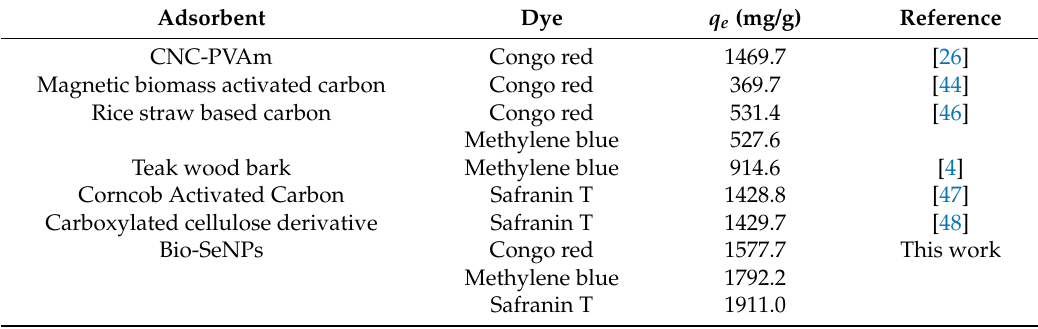
Table 2. Comparison of adsorption capacity of anionic dyes by some bio-based adsorbents. Adsorbent Dye q e (mg/g)